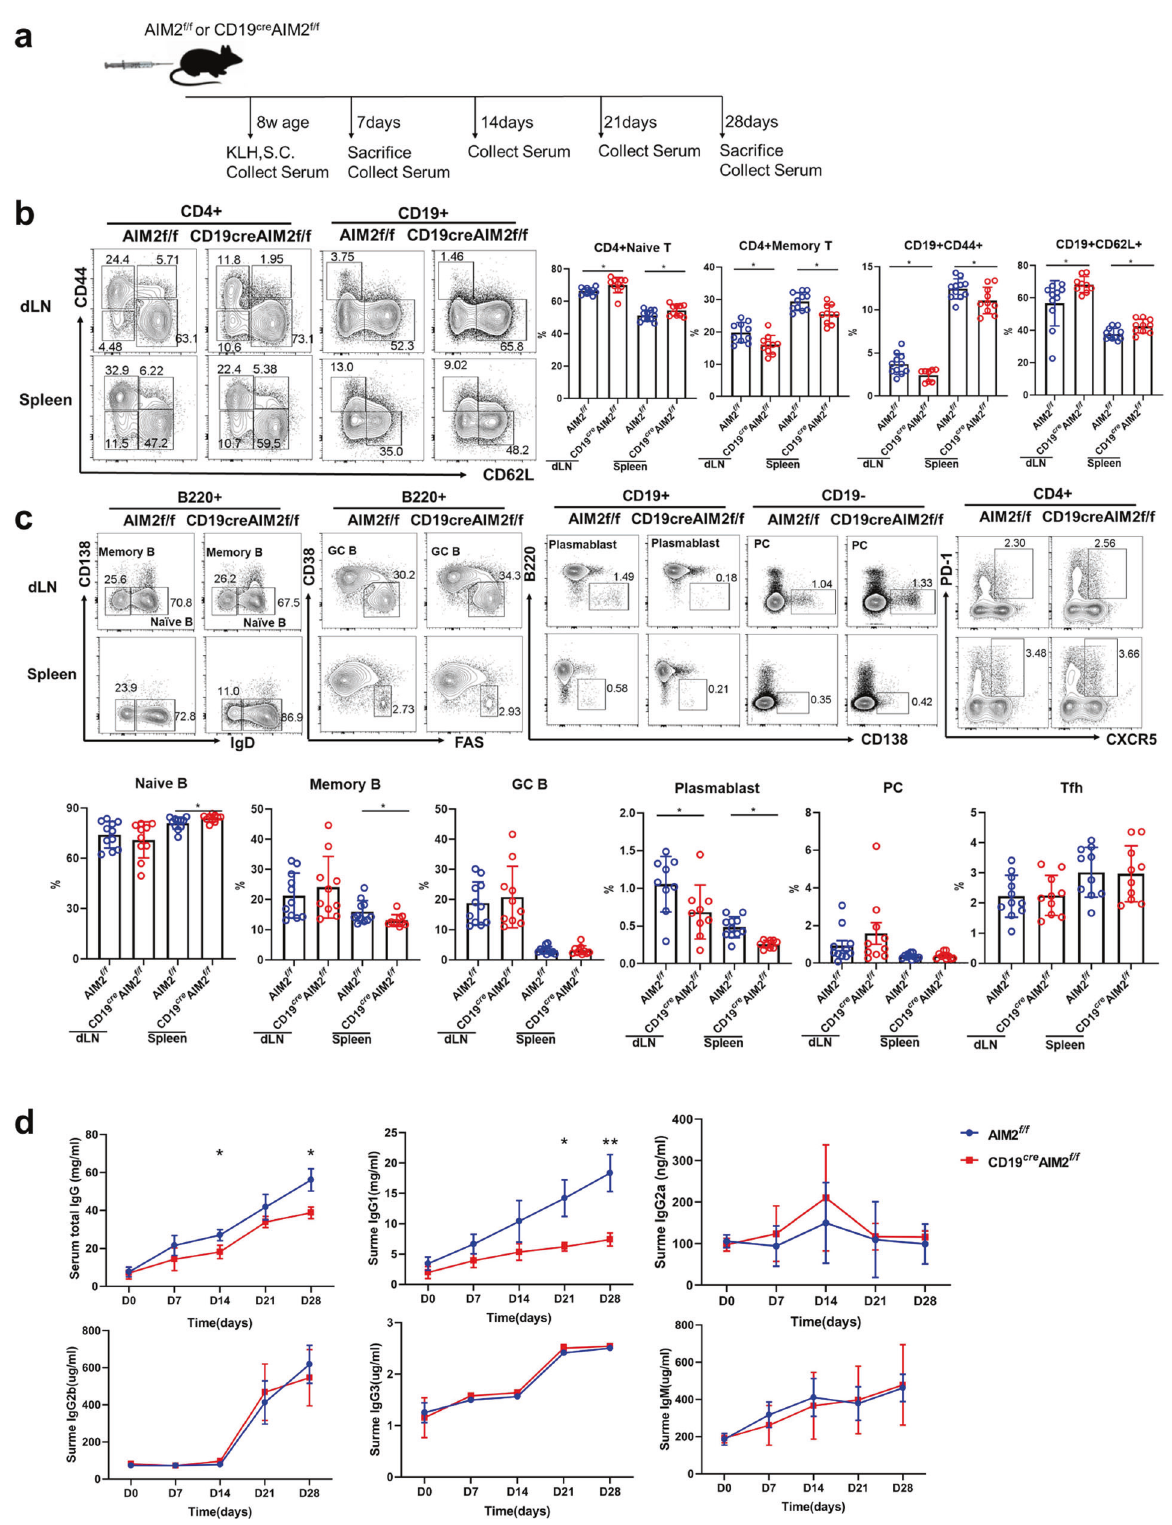
Fig. 3 The KLH-induced response in CD19 cre AIM2 f/f mice. a A schematic of the KLH-induced response experiments. On day 7 after KLH immunization, cells were collected from the dLNs and spleens of the CD19 cre AIM2 f/f mice and AIM2 f/f mice. b Representative fl ow cytometry diagrams and statistical analysis of the percentages of CD4 + naïve T cells, CD4 + memory T cells, CD19 + CD44 + B cells, and CD19 + CD62L + B cells in the dLNs and spleens of the CD19 cre AIM2 f/f mice and AIM2 f/f mice. c Representative fl ow cytometry diagrams and statistical analysis of the percentages of naïve B cells, memory B cells, GC B cells, plasmablast cells, plasma cells, and Tfh cells in the dLNs and spleens of the CD19 cre AIM2 f/f mice and AIM2 f/f mice. d The serum levels of total IgG, IgG1, IgG2a, IgG2b, IgG3, and IgM from the KLH-immunized mice on days 0, 7, 14, 21, and 28. Horizontal bars represent the mean ± SEM. * p < 0.05, ** p <